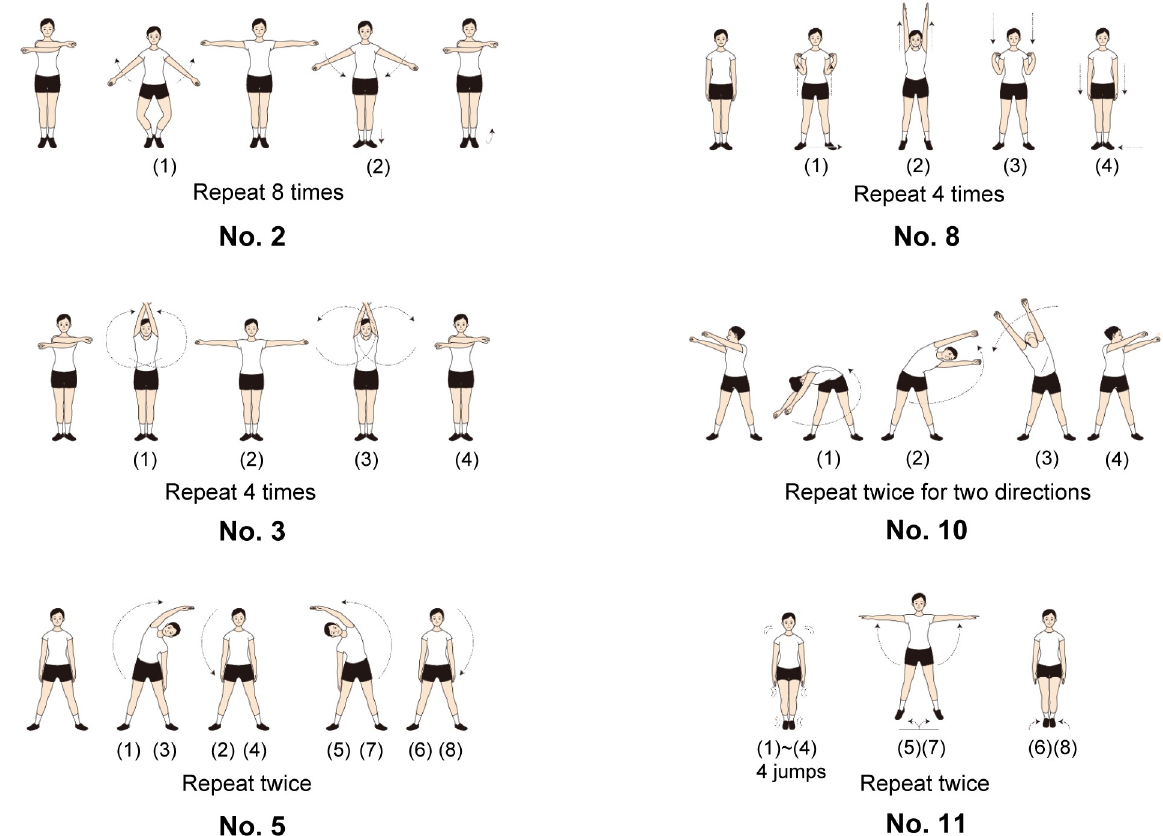
Fig 1. Exercises used in the experiments. This figure illustrates the six exercises from Radio Calisthenics routine No. 1 used in the present experiments. Numbers in parentheses indicate the approximate correspondence to the music beats. These illustrations are adapted from [67] with